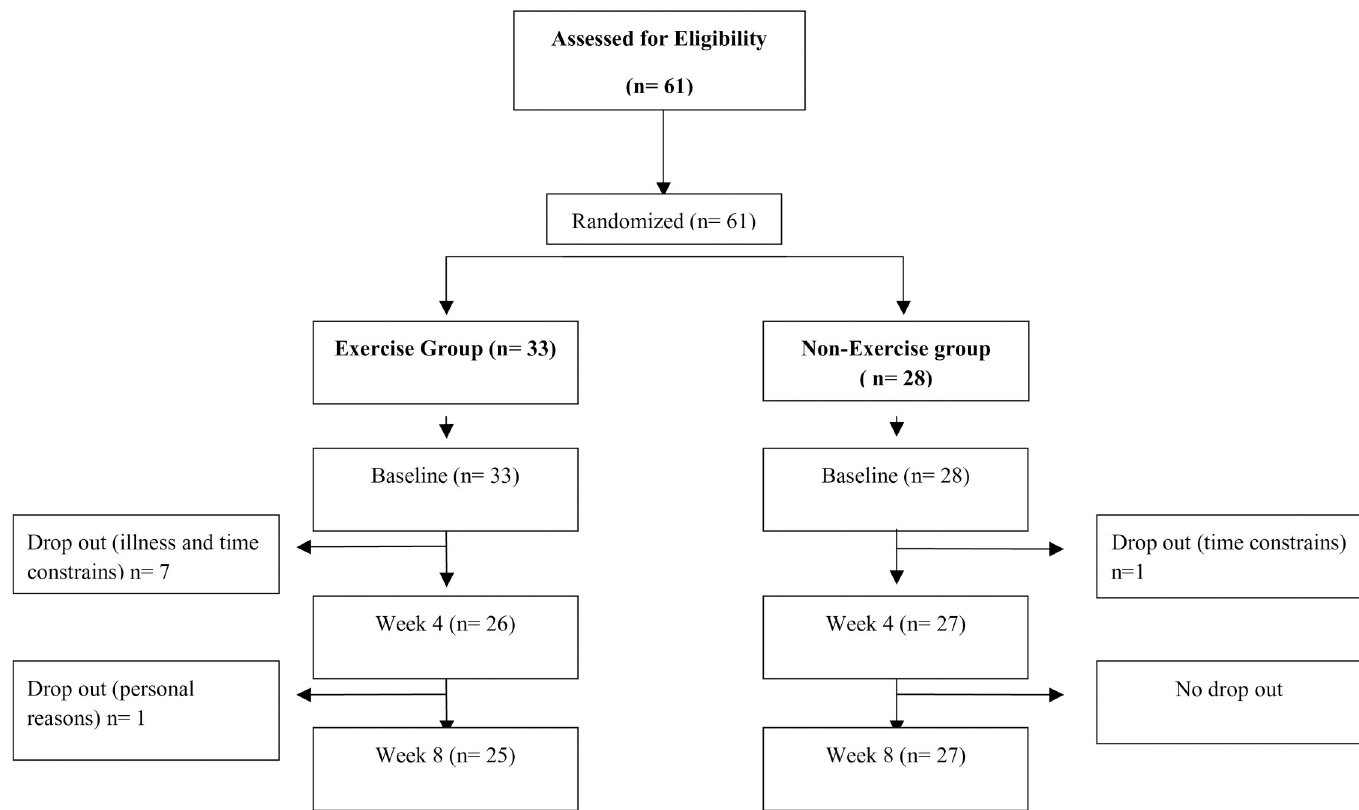
Fig 1. Consort flow diagram of participants’ recruitment and